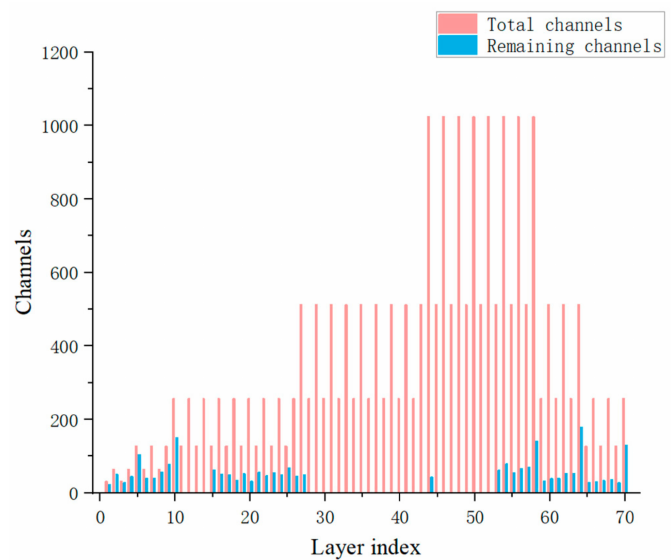
Figure 10. Channel changes before and after pruning.